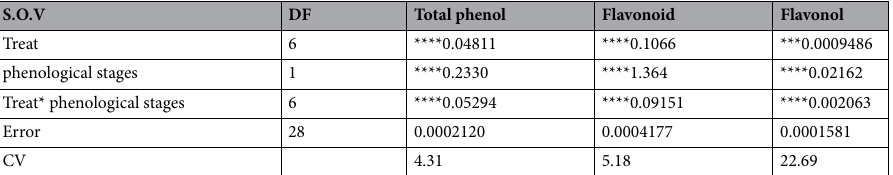
Table 3. Analysis of variance of the effect of different hormonal treatments on the content of phenylpropanoid compounds in the aerial part at different phenological stages of S. striata